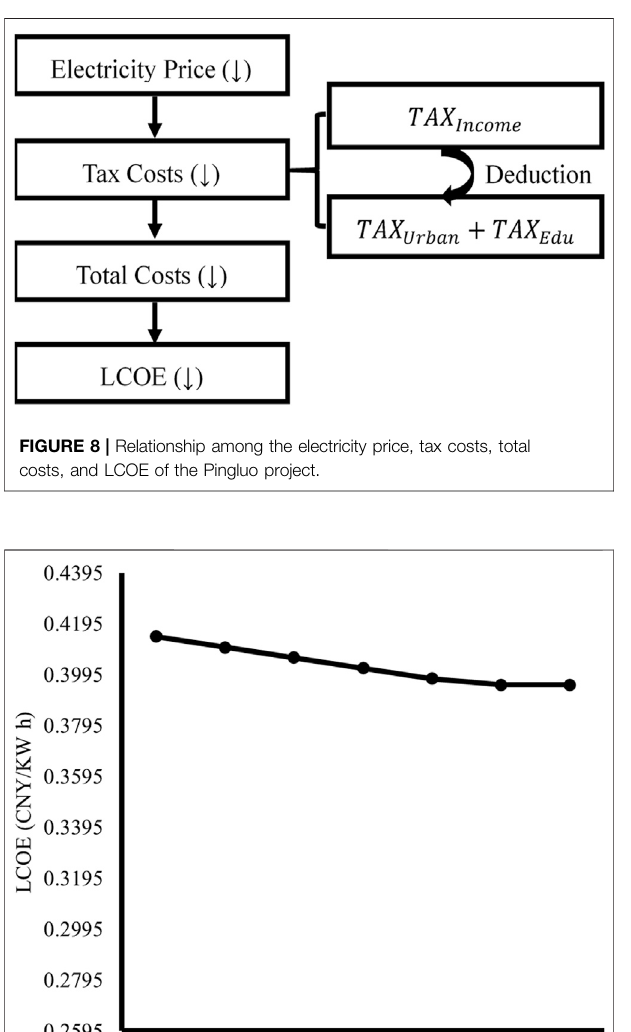
Figure 11 . The LCOE value was 0.3063 CNY/kW h in 2020 and has been developing with a decreasing trend.